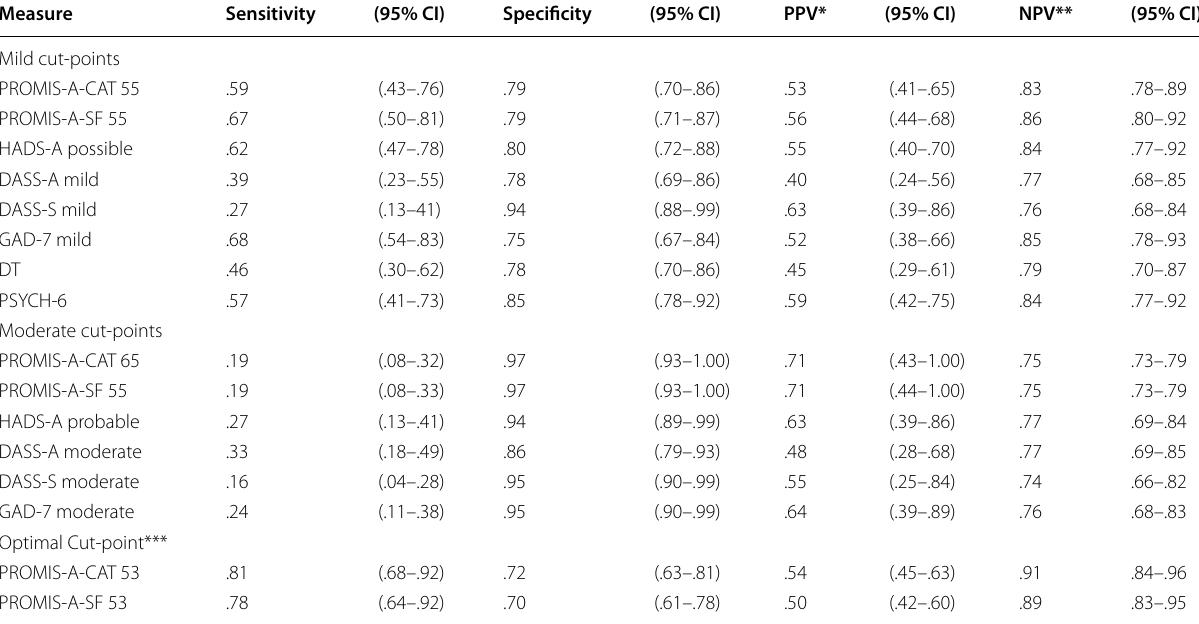
Table 3 Diagnostic accuracy of legacy measures at established cut-points compared with diagnosis of Any Anxiety Disorder using the Structured Clinical Interview for DSM disorders (SCID)